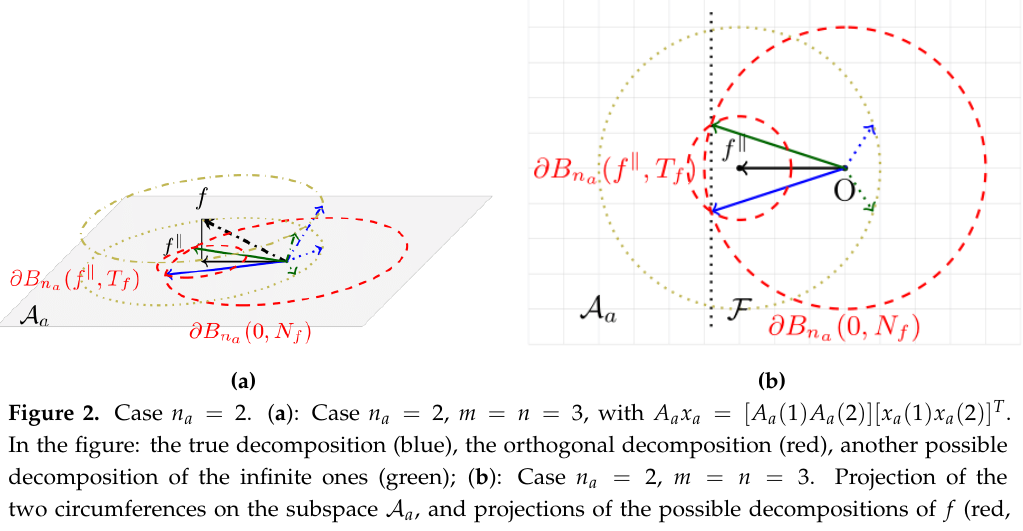
Figure 2. Case n a = 2. ( a ): Case n a = 2, m = n = 3, with A a x a = [ A a ( 1 ) A a ( 2 )][ x a ( 1 ) x a ( 2 )] T . In the figure: the true decomposition (blue), the orthogonal decomposition (red), another possible decomposition of the infinite ones (green); ( b ): Case n a = 2, m = n = 3. Projection of the two circumferences on the subspace A a , and projections of the possible decompositions of f (red, blue and